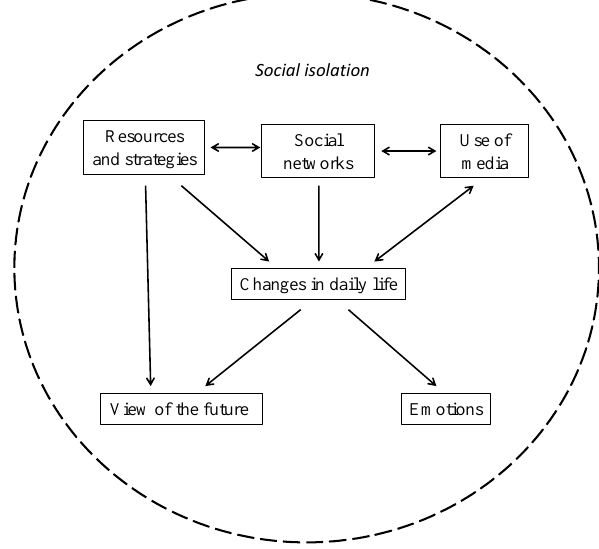
Figure 1. Map of the relationships between themes.